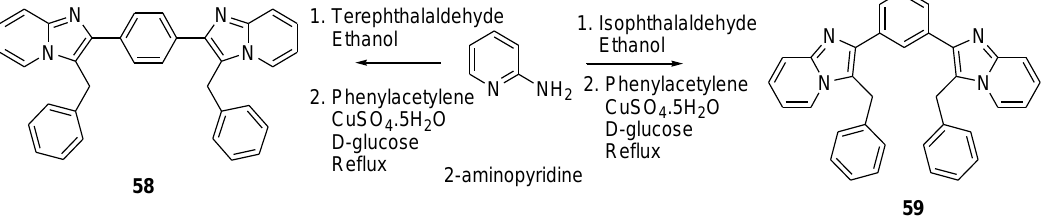
Figure 13. Reaction scheme of the transformation of 2-aminopyridine into the symmetric imidazo[1,2 − a ]pyridine dimers 58 and 59 .